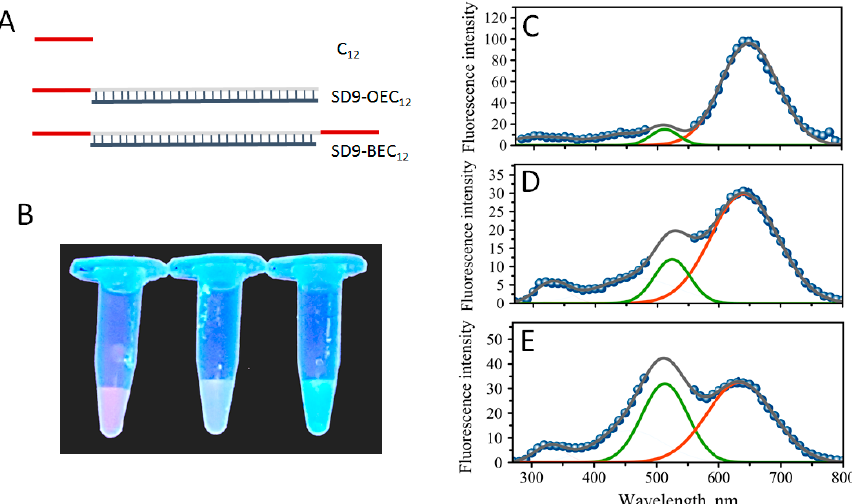
Figure 1. ( A ) Schematic representation of the template design, ( B ) a photograph of fluorescent glowing of solutions containing fluorescent silver nanoclusters (AgNC) templated on C 12 (red), SD9-OEC 12 (yellow), and SD9-BEC 12 (green), (left to right) under the UV excitation on a trans-illuminator. Fluorescence spectra of AgNCs recorded with 254 nm excitation wavelength for the following templates ( C ) C 12 , ( D ) SD9-OEC 12 , and ( E ) SD9-BEC 12 . Gaps in the spectra are due to the removal of the second order scattering. Green and red solid lines are plotted as “guide for the eye” in the positions of major “green” and “red” emission